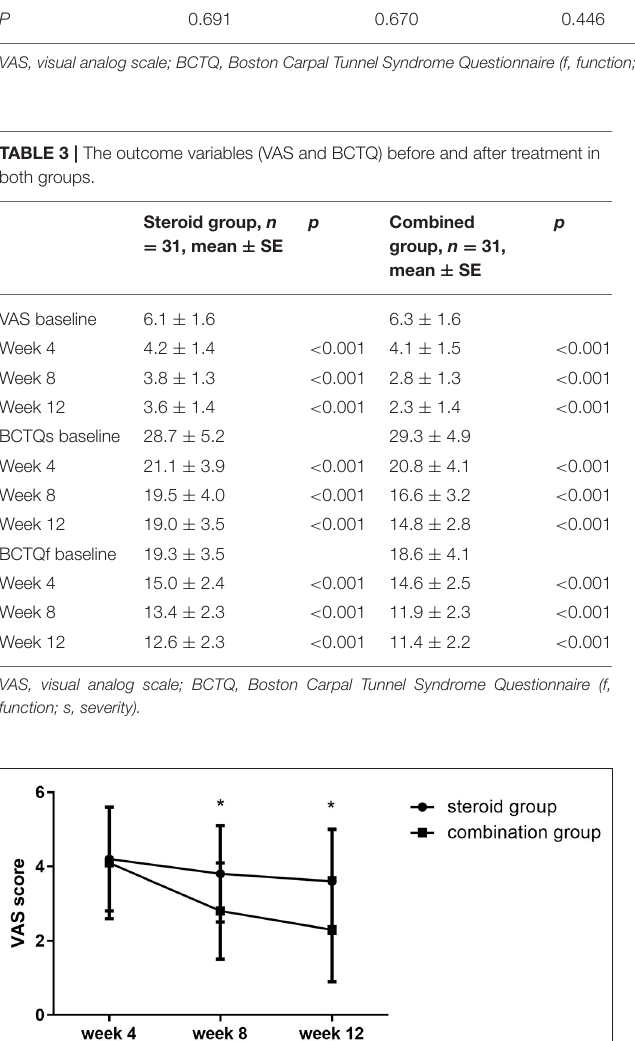
TABLE 2 | Comparison of VAS and BCTQ scores at baseline and week 4 between groups. Baseline Week 4 VAS, mean ± SD BCTQs, mean ± BCTQf, mean ± VAS, mean ± SD BCTQs, mean ± SD SD SD